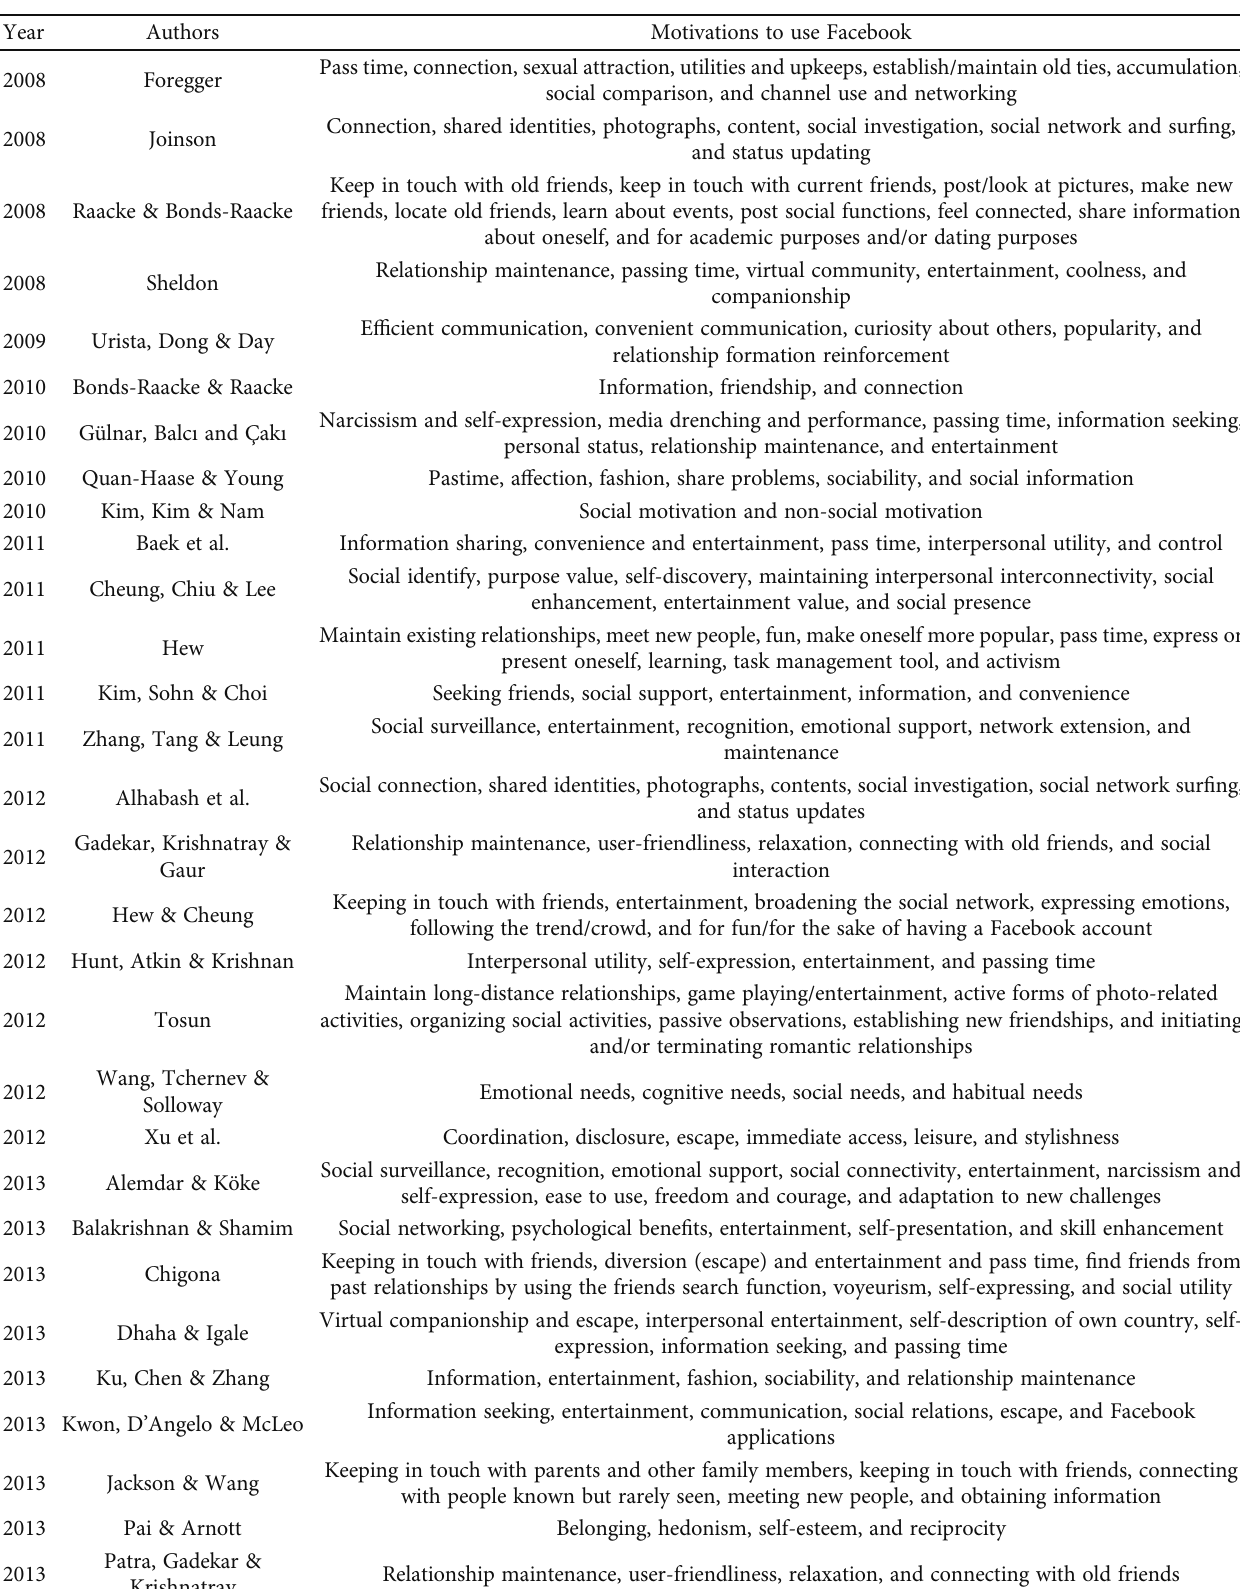
Table 1: Review of the